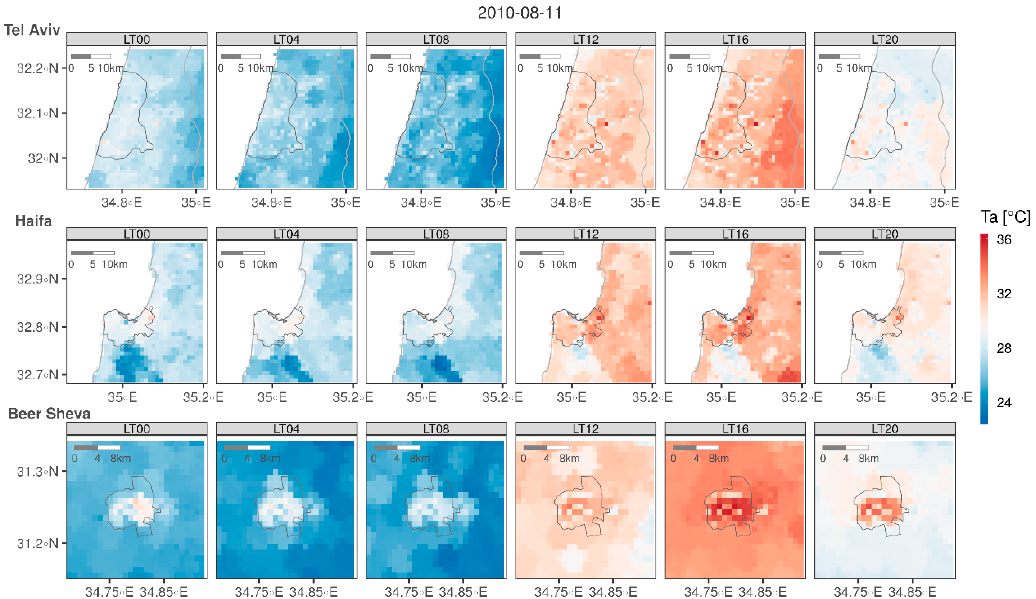
Figure 17. The simulated hourly 1 × 1 km 2 Ta at 4-h intervals for three metropolitan areas in Israel (Tel Aviv, Haifa, and Beer Sheva) on 11 August 2010.